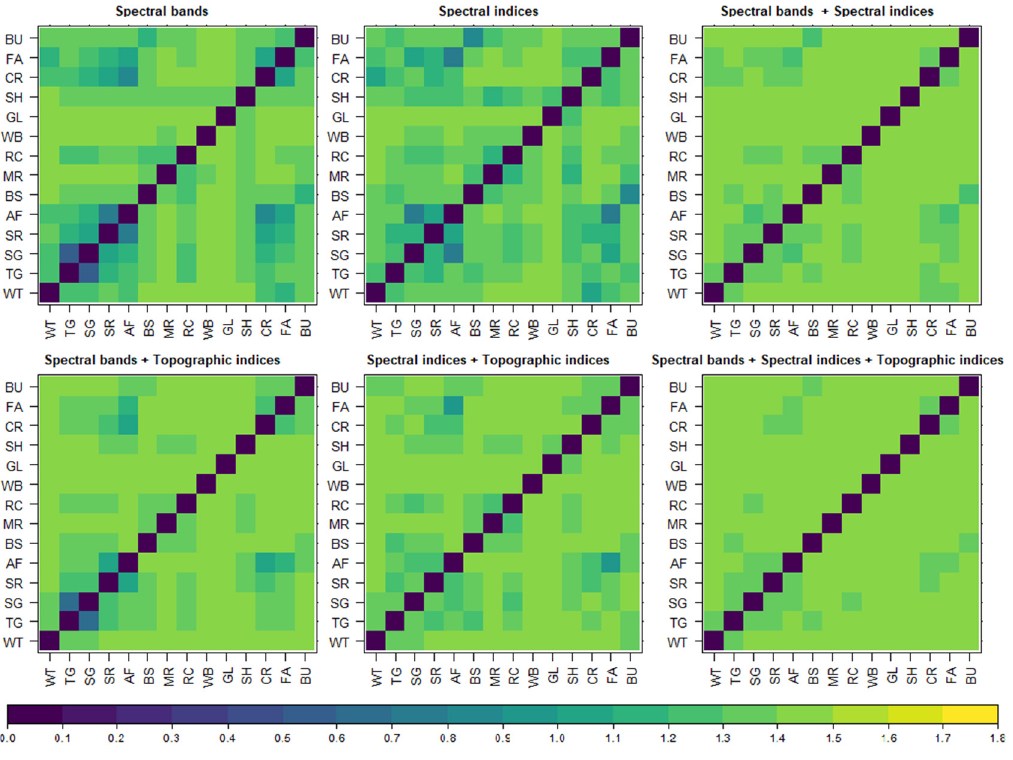
Figure 3. Jefferies–Matusita distance separability matrix for training classes. Notes: WT—Wetlands; TG—Tall grass; SG—Short grass; SR—Shrublands; AF—Andean forest; BS—Bare soil; MR—Moraine; RC—Rocky; WB—Water bodies; GL—Glacier; SH—Shadows, FA—Forested reas; CR—Croplands; BU—Built-up.